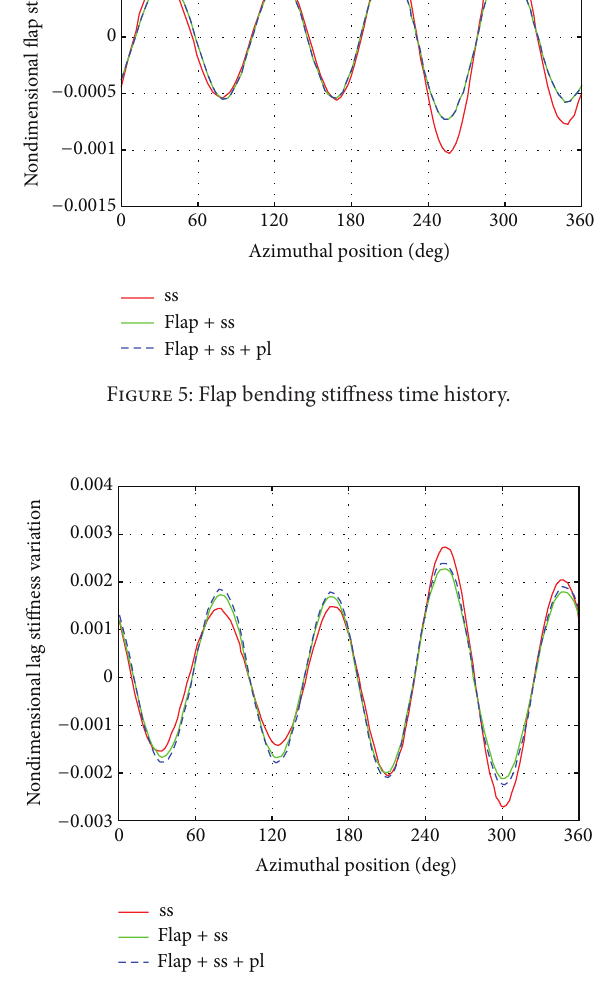
Figure 6: Lag bending stiffness time history.